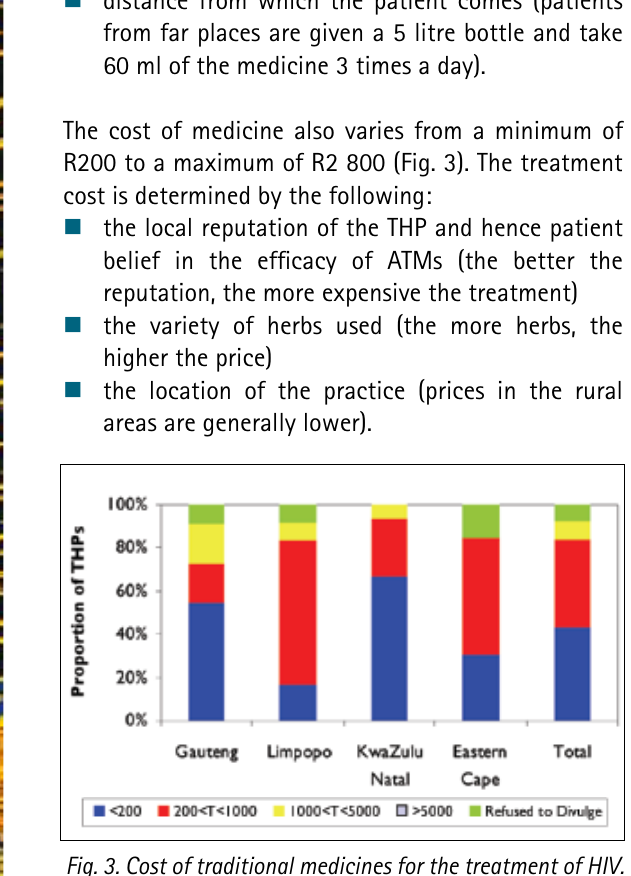
Fig. 3. Cost of traditional medicines for the treatment of